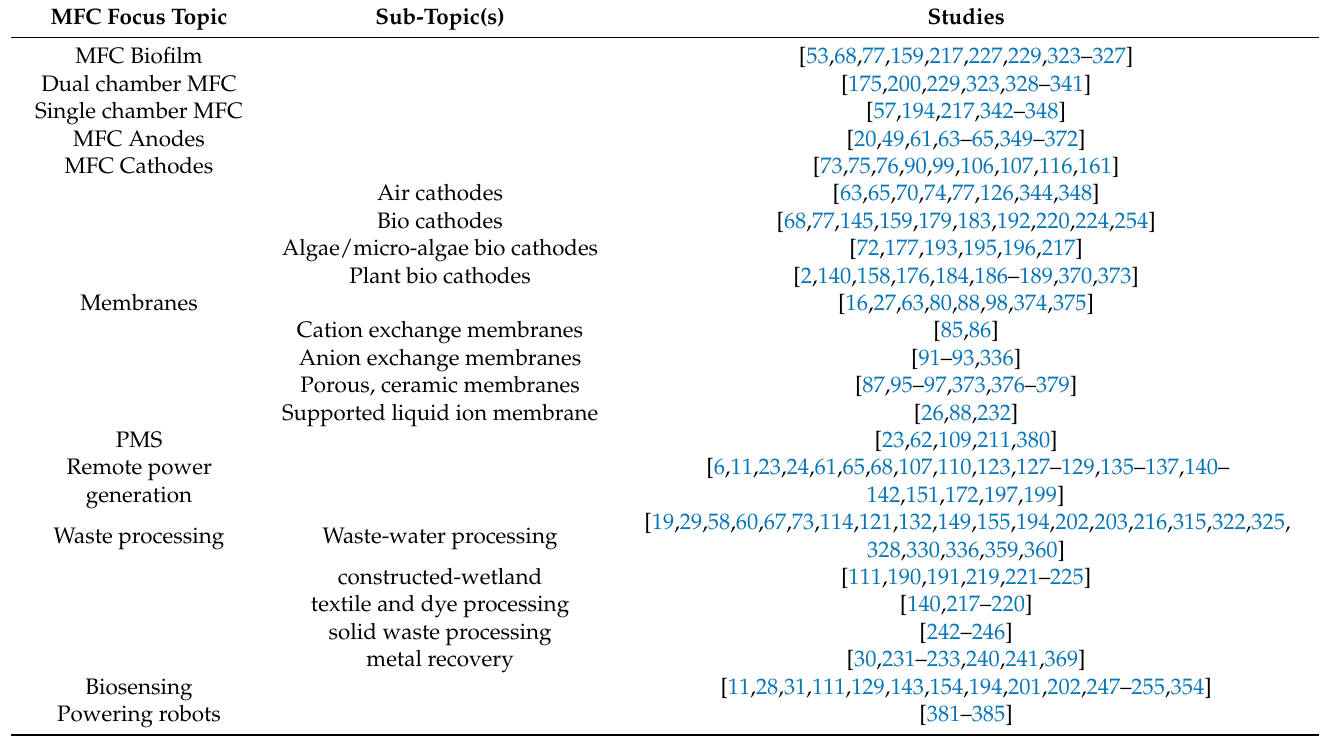
Table 1. Summary of reviewed works on MFCs.